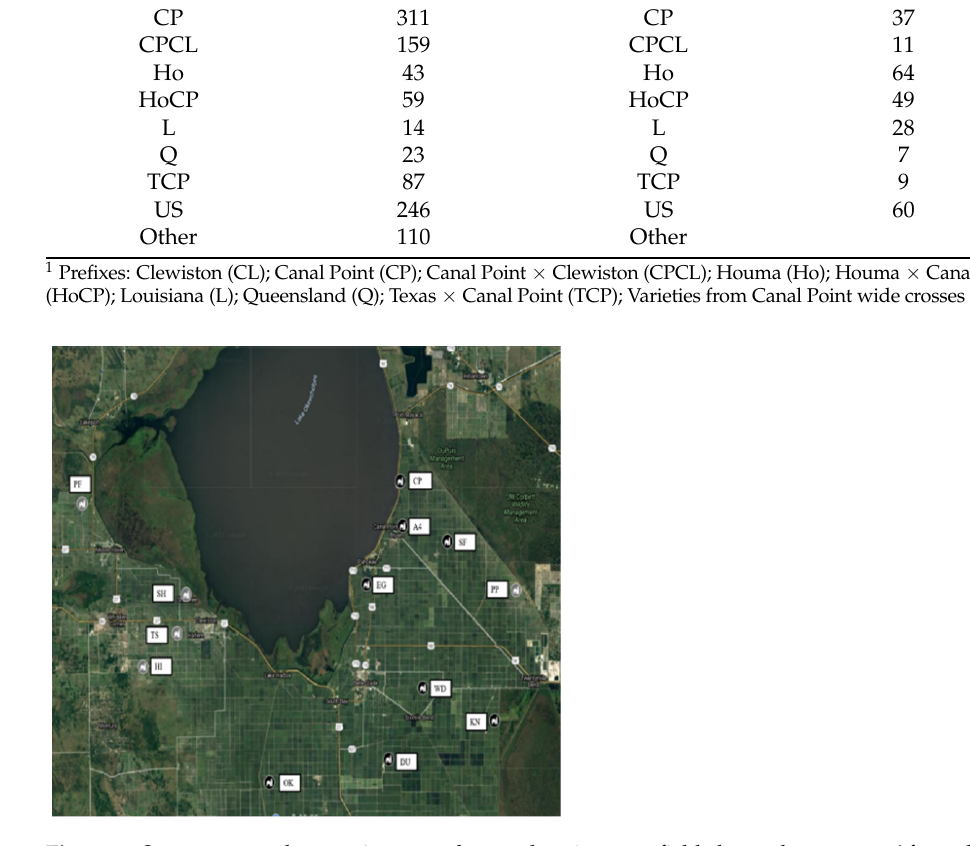
Figure 1. Sugarcane seedcane primary and secondary increase fields located at growers’ farm during 2015 to 2019. Muck soil fields were located at Area 4 (A4), Duda (DU), Eastgate (EG), Knight (KN), Okeelanta (OK), South Florida (SF), and Wedgeworth (WD). Sand soil fields were located at Hilliard brothers (HI), Pahokee Produce (PP), Perry Farm (PF), Shawnee Farm (SH), and Townsite